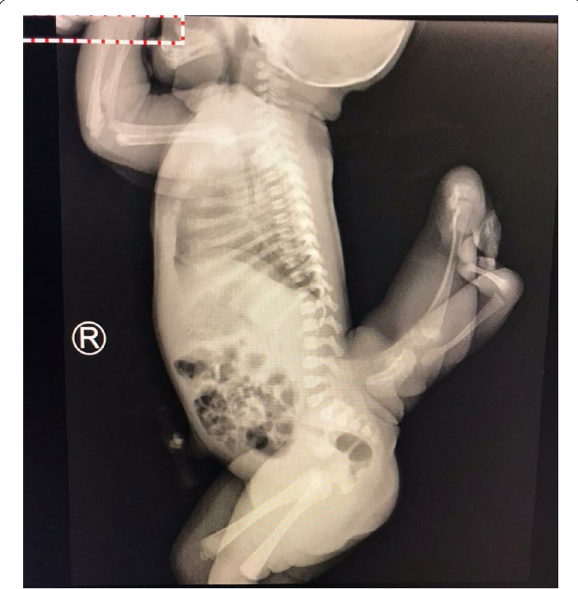
Fig. 1 Extra limb arising from lumbosacral region